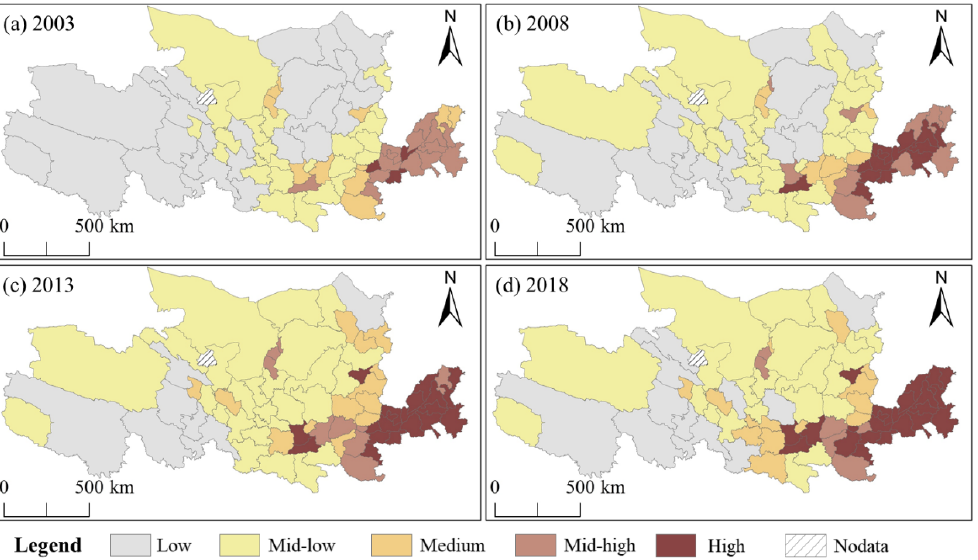
Figure 3. Spatio-temporal pattern of RLUT in the YRB. ( a – d ) denote the spatio-temporal pattern of RLUT for 2003, 2008, 2013 and 2018, respectively.